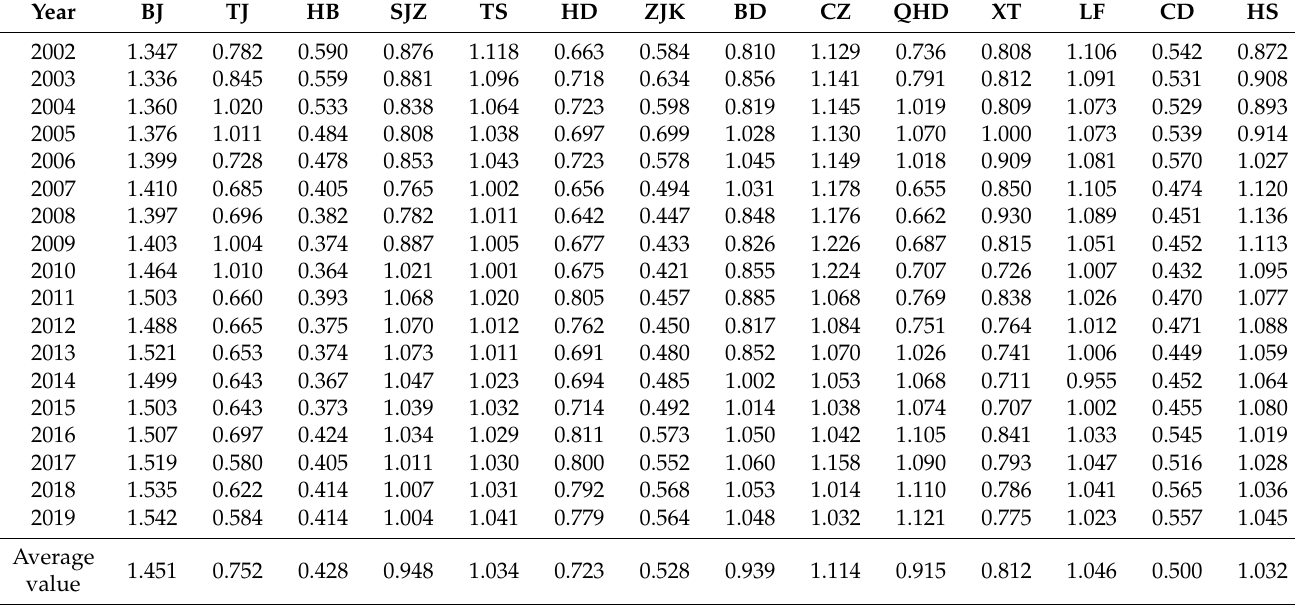
Table 5. The economic efficiency value of UCL in the BTH